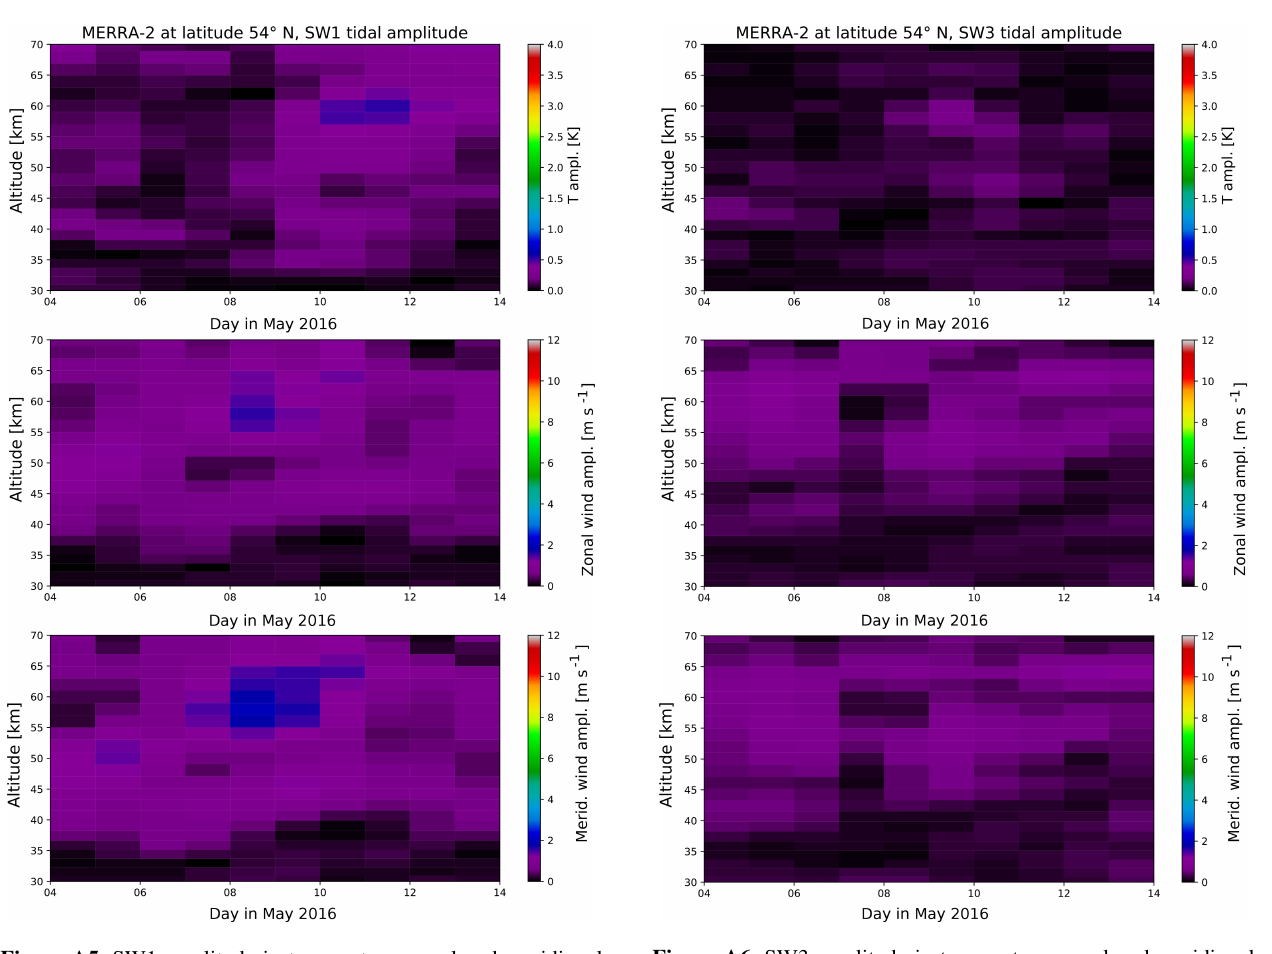
Figure A5. SW1 amplitude in temperature, zonal and meridional wind from global MERRA-2 fields at the latitude of 54 ◦ N.